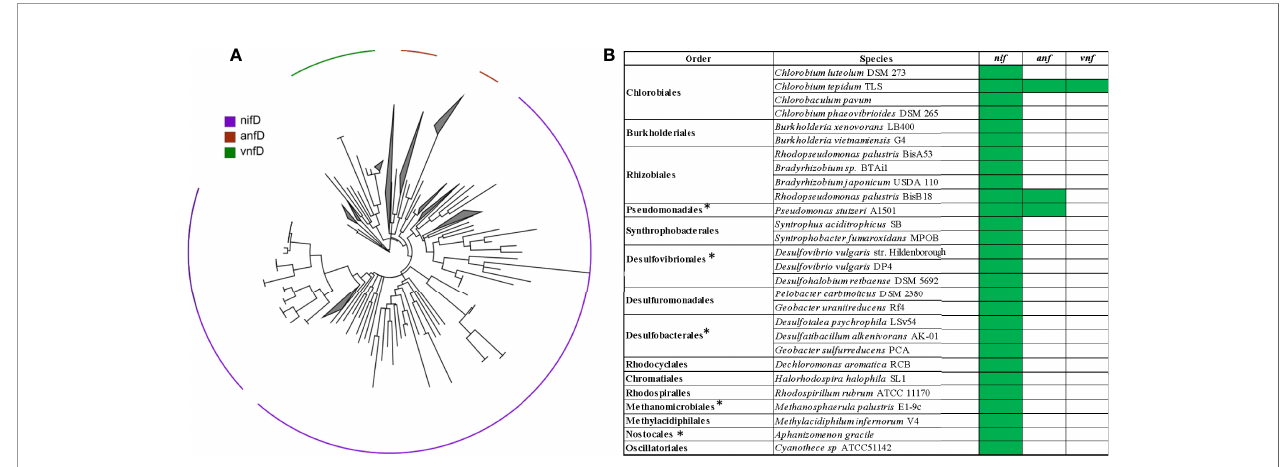
FIGURE 2 | Presence of nitrogenase genes in the metagenomes and -transcriptomes. (A) The maximum likelihood tree shows the detected diversity based on nifD , anfD , and vnfD . (B) Species closest related to the detected diazotrophs, the presence of nif, anf , and vnf is indicated in green. Note that the majority of diazotrophs possesses nif -nitrogenase genes only. * mark genera, of which we found representatives in our previous nifH -based study.